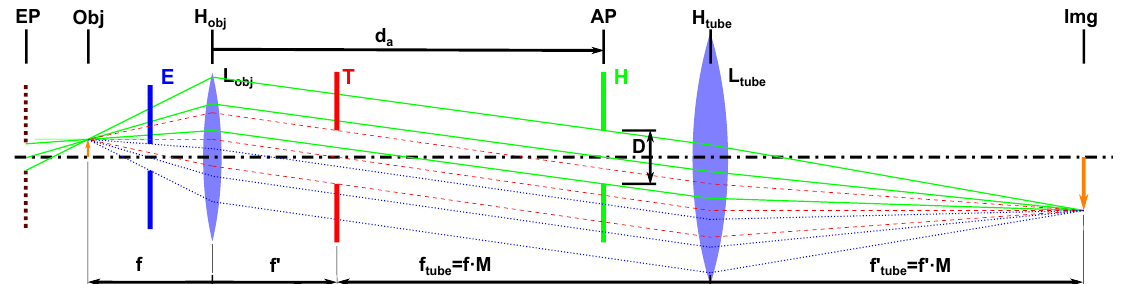
Figure 1. Schematic of a 4f-inspection microscope consisting of an objective lens (L obj ), a tube lens (L tube ) with their corresponding principal plains (H obj , H tube ) and an image sensor (Img). The magnification M is defined by the fraction for the tube and objective lens’ focal length ( f tube the aperture is located in the back focal plane of the objective lens (T). In this case, the principal ray in the object space is parallel to the optical axis independent from the object’s height. The entrance pupil is at infinite distance, resulting in the telecentric parallax free projection properties. If the aperture is shifted closer to the object ( E ), the principal ray is deflected towards the entrance pupil location at a finite distance (entocentric projection), resulting in a field-height-dependent observation angle. If the aperture is shifted towards the tube lens ( H ), the entrance pupil (EP), which is defined as the object sided image of the pupil, virtually lays behind the object (hypercentric projection). As the physically acting entrance pupil is only a virtual image, the geometric projection center can be shifted very close to the object without mechanical interference, resulting in a high parallax